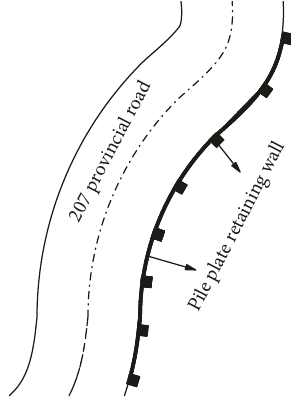
Figure 19: Schematic of the topography of the